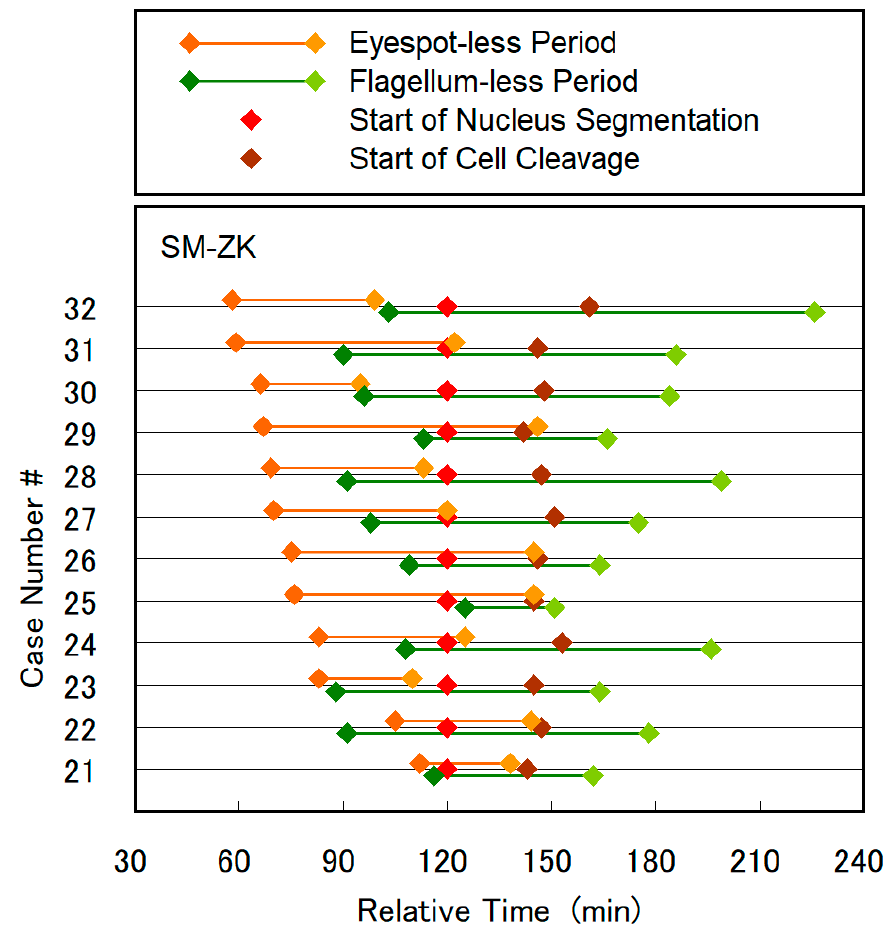
Figure 8. The period of disappearance of the eyespot and flagellum plotted for 12 SM-ZK cells, together with the initiation time of nucleus segmentation and cell cleavage. In the plot, the initiation time of nucleus segmentation was used as the standard timing (120 min). Case number was sorted by the time of eyespot disappearance (earlier to later). The case #30 corresponds to Figures 3, 5, and 6, and Movie S3. See Figure S5 for WT cells. Figure 10 shows the histogram of cell division time (the duration the cell remained motionless during long-term observation) and the difference in swimming start time between two daughter cells, based on data from 26 individual instances of SM-ZK cell division. The average duration of cell division and difference in swimming start times were 157 and 38 min, respectively, and no correlation was found between these two